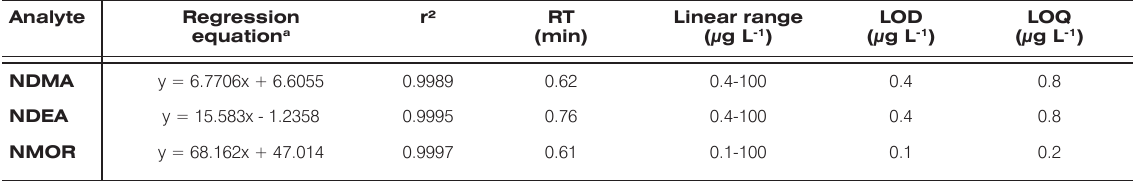
Table 3. The regression equation, correlation coefficient (r²), retention time (RT), linearity, instrumental detection limit (LOD, S/N = 3), and quantification limit (LOQ, S/N = 10) using UHPLC/MS/MS method for N-nitrosamines. Analyte